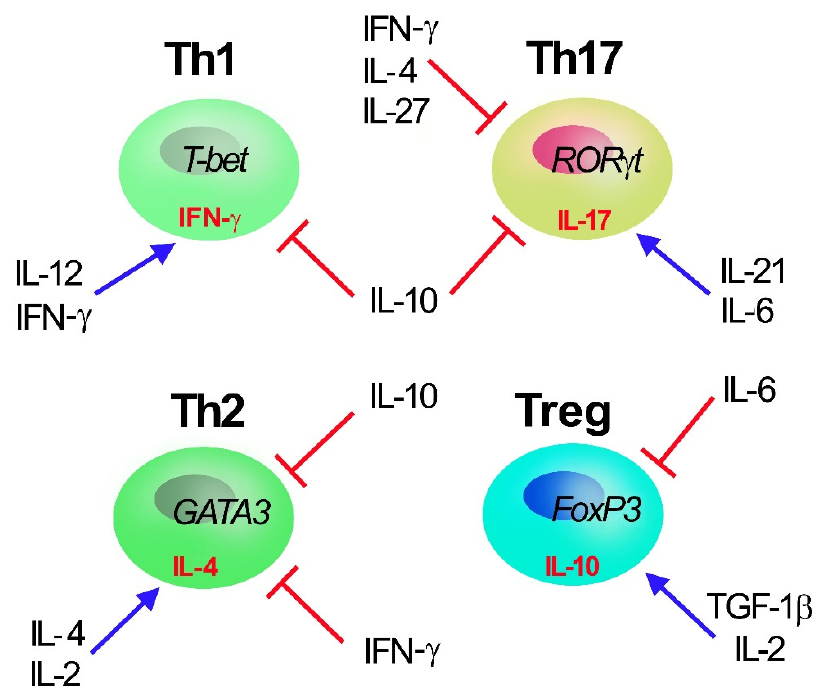
Figure 1. Th1, Th2, Th17, and Treg T CD4+ subset cells. Master transcription factors promoting Th polarization are reported inside cells (T-bet, GATA3, ROR γ T and Foxp3 for Th1, Th2, Th17, and Treg cell, respectively) together with selective secreted cytokines ( γ -IFN, IL-4, IL-17 and IL-10 for Th1, Th2, Th17, and Treg cell, respectively). The main cytokines (IL-2, IL-4, IL-6, IL-12, IL-10, IL-21, IFN- γ , and TGF-1 β ) regulating Th polarization are reported: IL-10, secreted by Treg, acts as major inhibiting factors of Th polarization and proliferation.